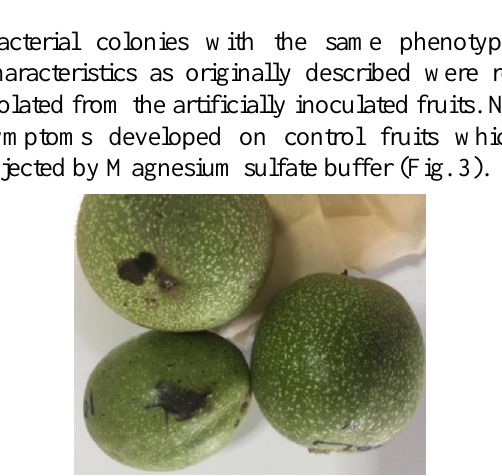
Fig. 3. Production of water-soaking after bacterial inoculation to mesocarp of immature walnut fruit (both fruits in the left) and negative control by Magnesium sulfate buffer which injected into the single right